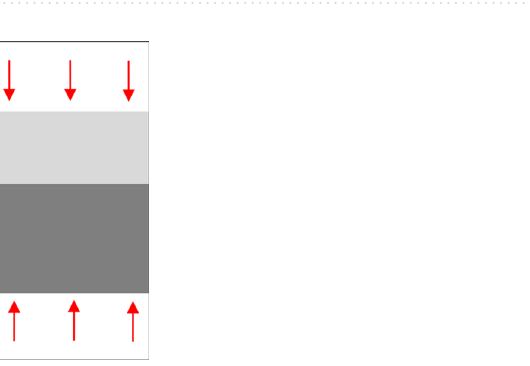
Figure 3. SEM images of IPS from vertically aligned hexagonally patterned IPS polymeric nanowires to collapsed IPS polymeric nanowires. For different ( a – f ) duration of thermal NIL, and the insets show cross- sectional view of nanowires.